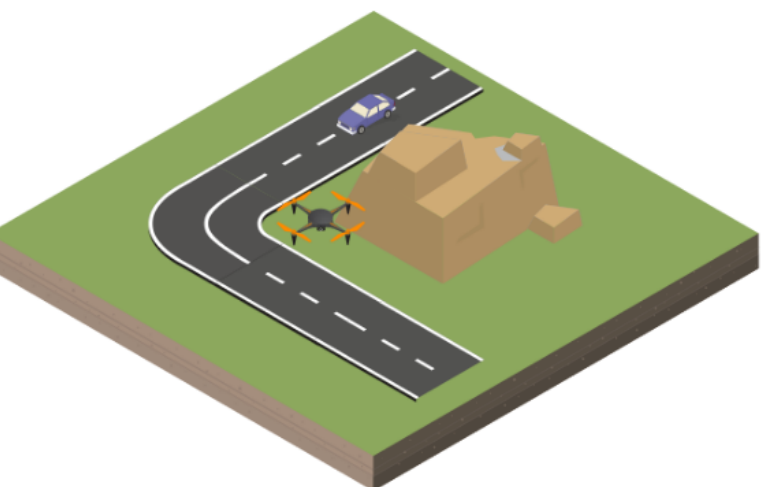
Figure 1. An illustration of a simple scenario. The vehicle’s perception is limited by the environment, and it can then rely on the drone to gather data instead.